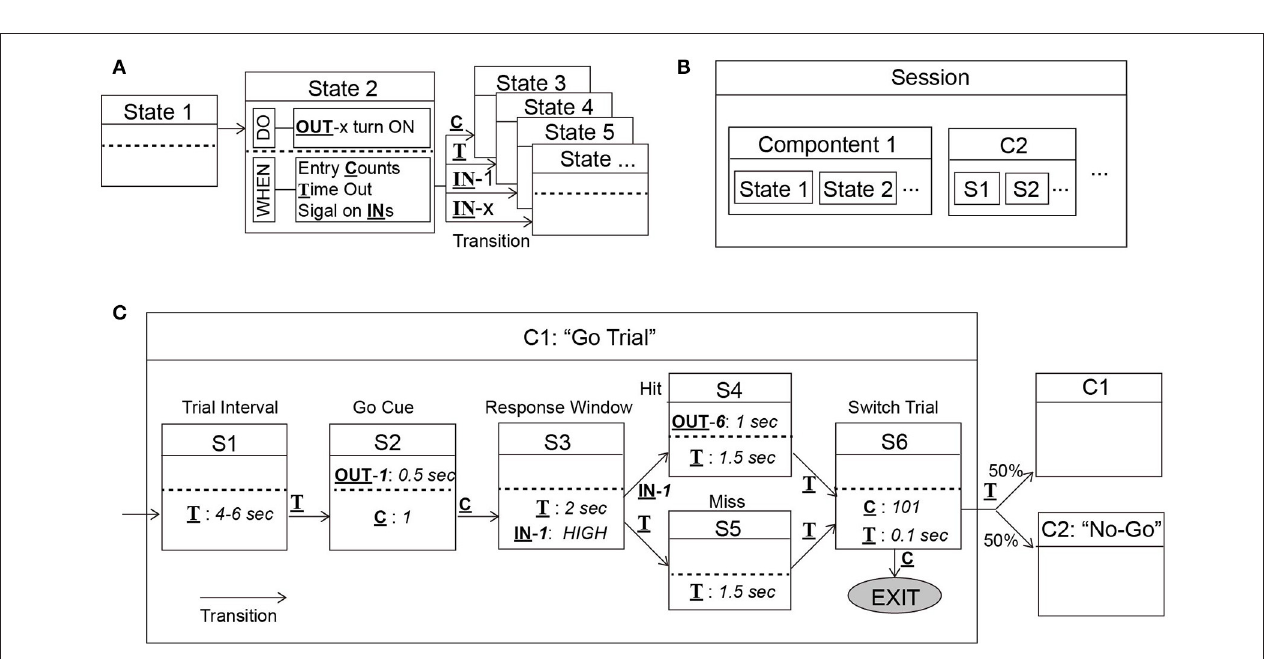
FIGURE 2 | Diagram of the State Notation principle utilized by ArControl. (A) The State has a do-function to deliver stimulus, and when-functions that master the transitions cross States. ( B ) Component (abbr. C) and Session structures are the primary and the secondary collection of States (abbr. S). (C) Illustration of a Go Trial in the Go/No-Go